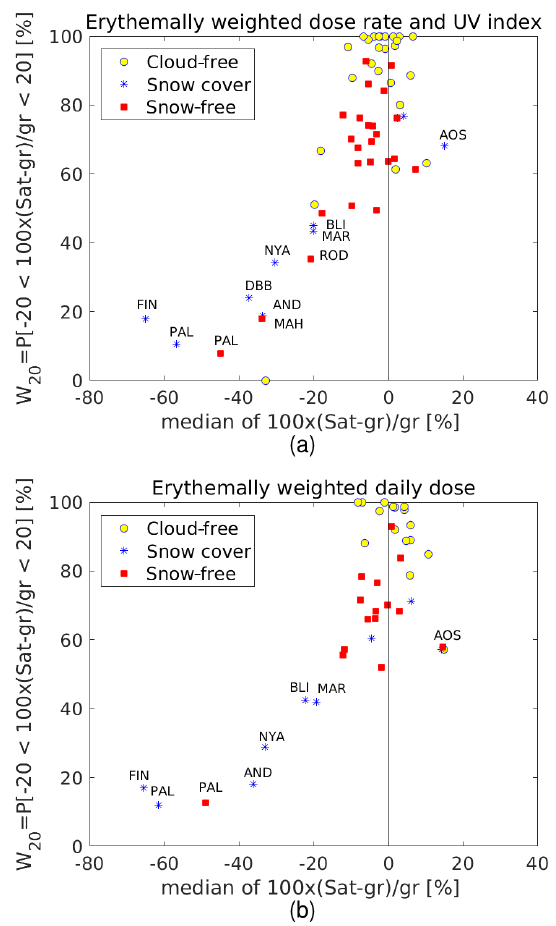
Figure 8. W 20 in function of ρ for the (a) overpass erythemally weighted dose rate and UV index (b) erythemally weighted daily dose. Figure 9. The absolute difference between the TROPOMI overpass UV index and ground-based measurement at Ny-Ålesund as (a) his- togram binned with 0.1 interval and (b) a function of